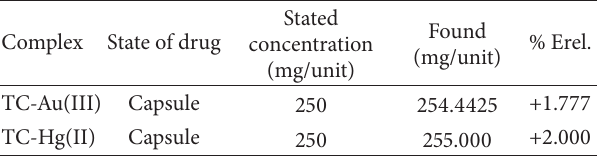
Table 8: Relative percentage error for determination of TC-Au(III) and TC-Hg(II) complexes by HPLC direct